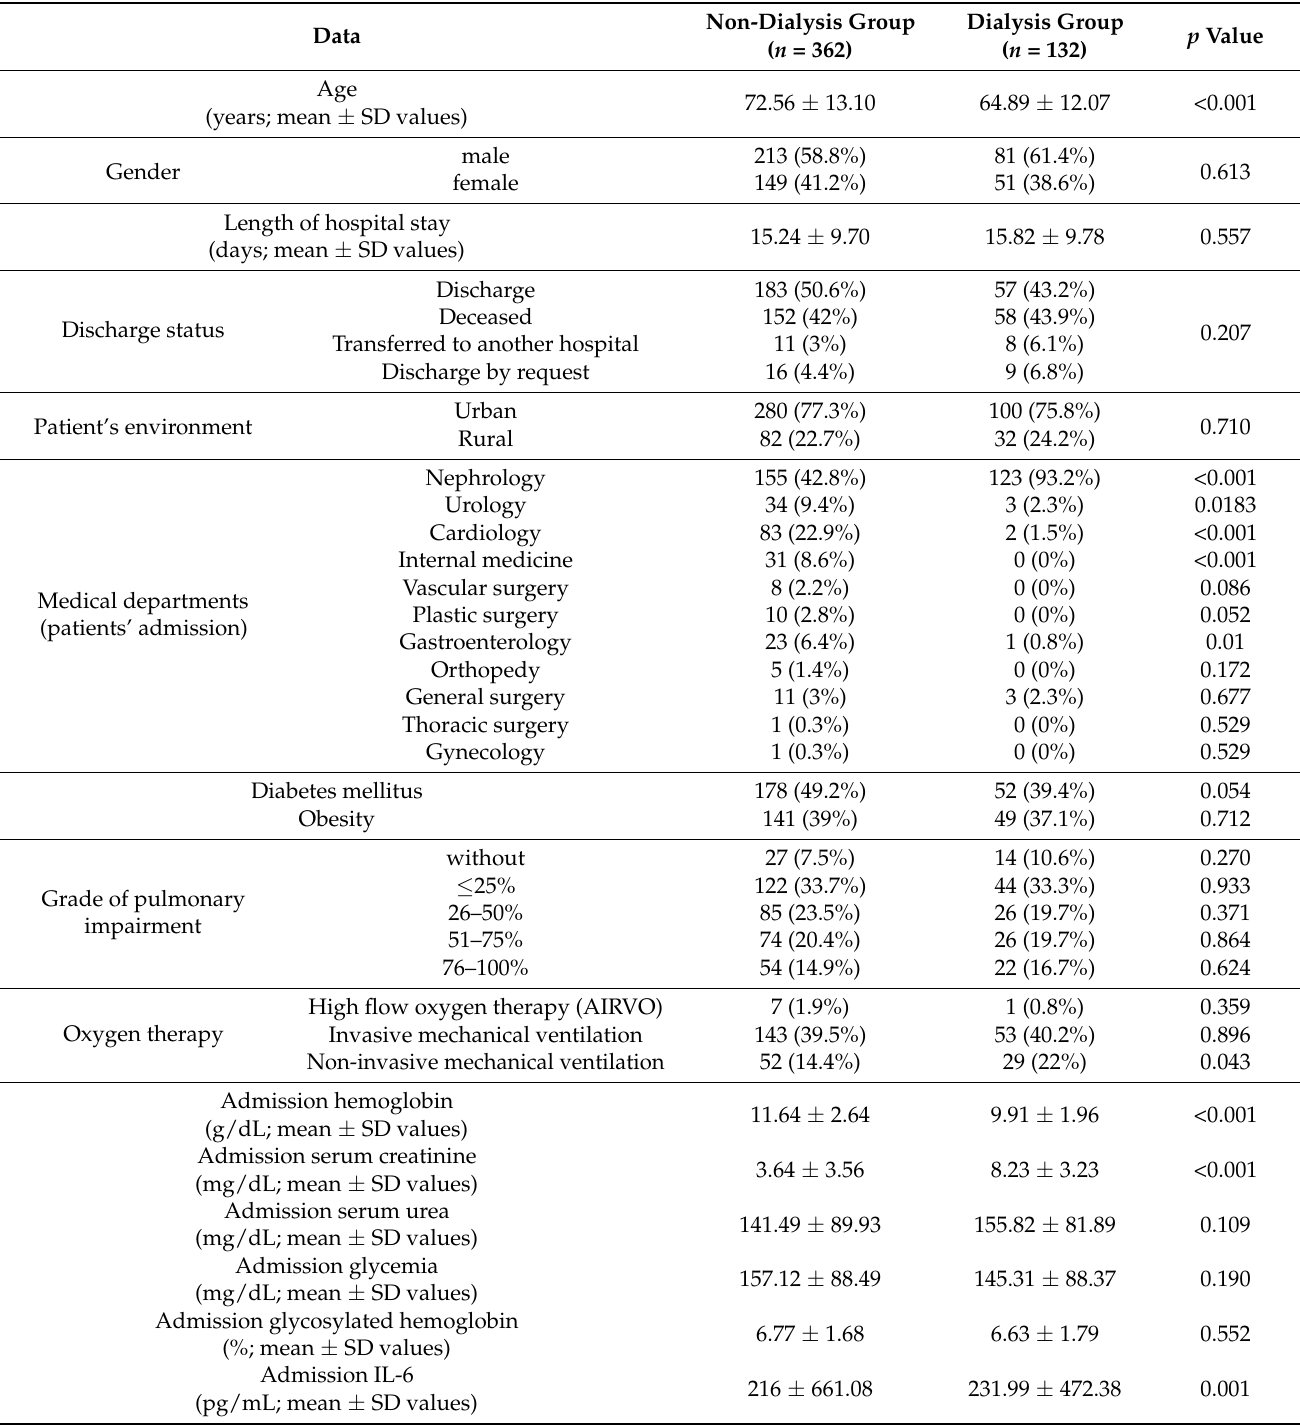
Table 2. Patients’ characteristics in both